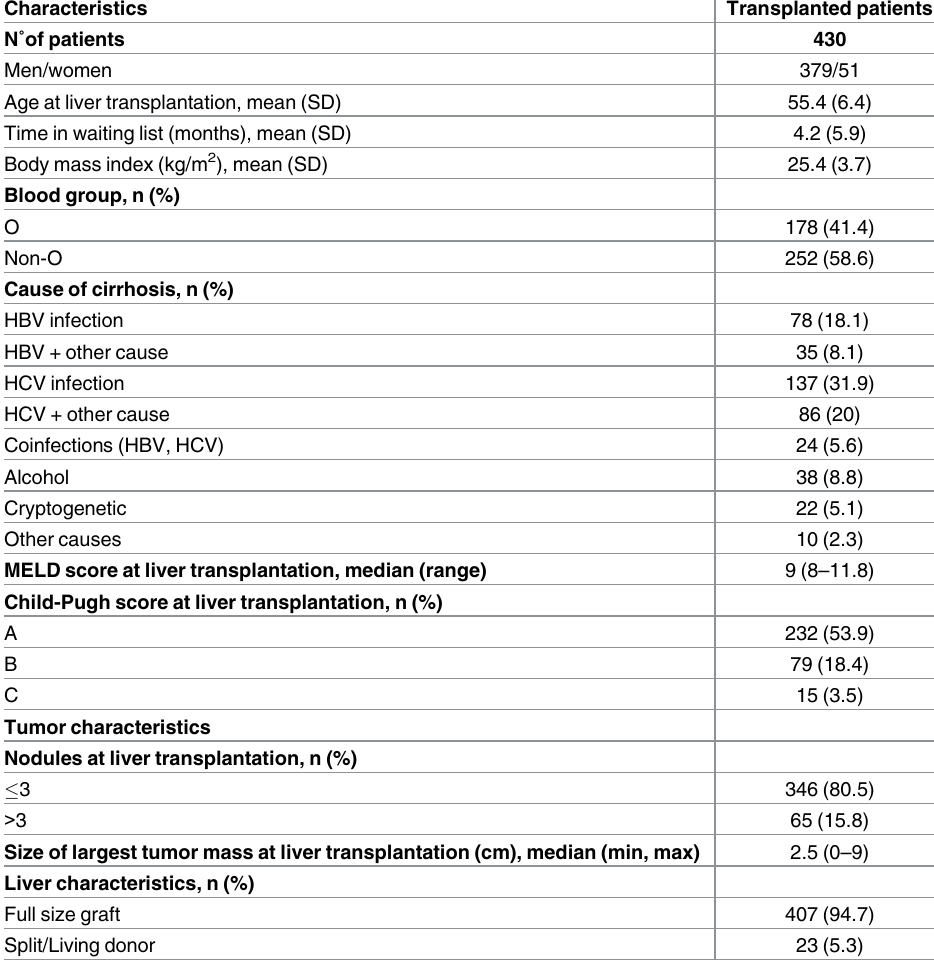
Table 1. Characteristics of patients who underwent liver